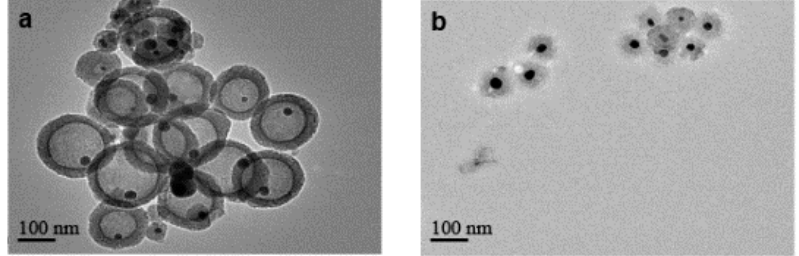
Figure 5. Characterization of the prepared nanoparticles without substrate after reaction under argon by TEM images: ( a ) prepared by low concentration of C 7 H 6 O, ( b ) prepared by CH 2 O.